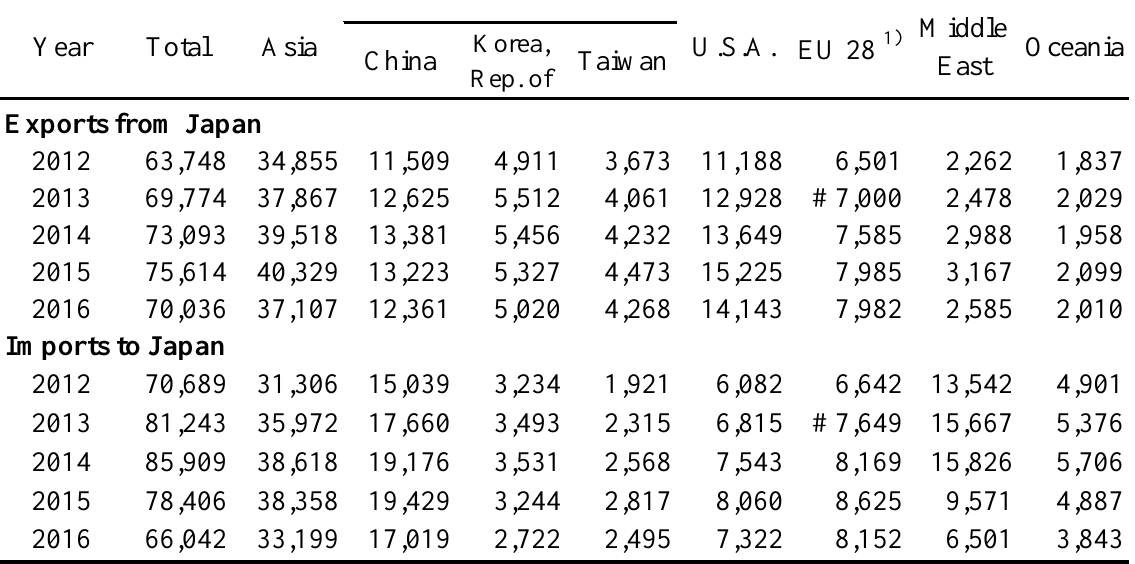
Korea, China Taiwan Rep. of